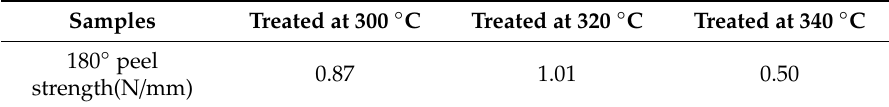
Table 1. Peel strength of the FCCL prepared at different hot-press temperatures. Samples